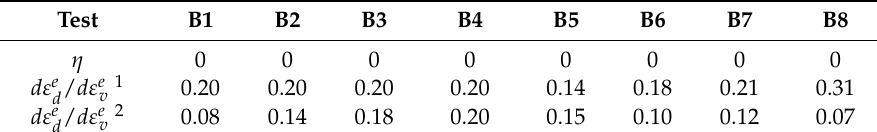
Table 3. Strain path directions for isotropic loading [31].